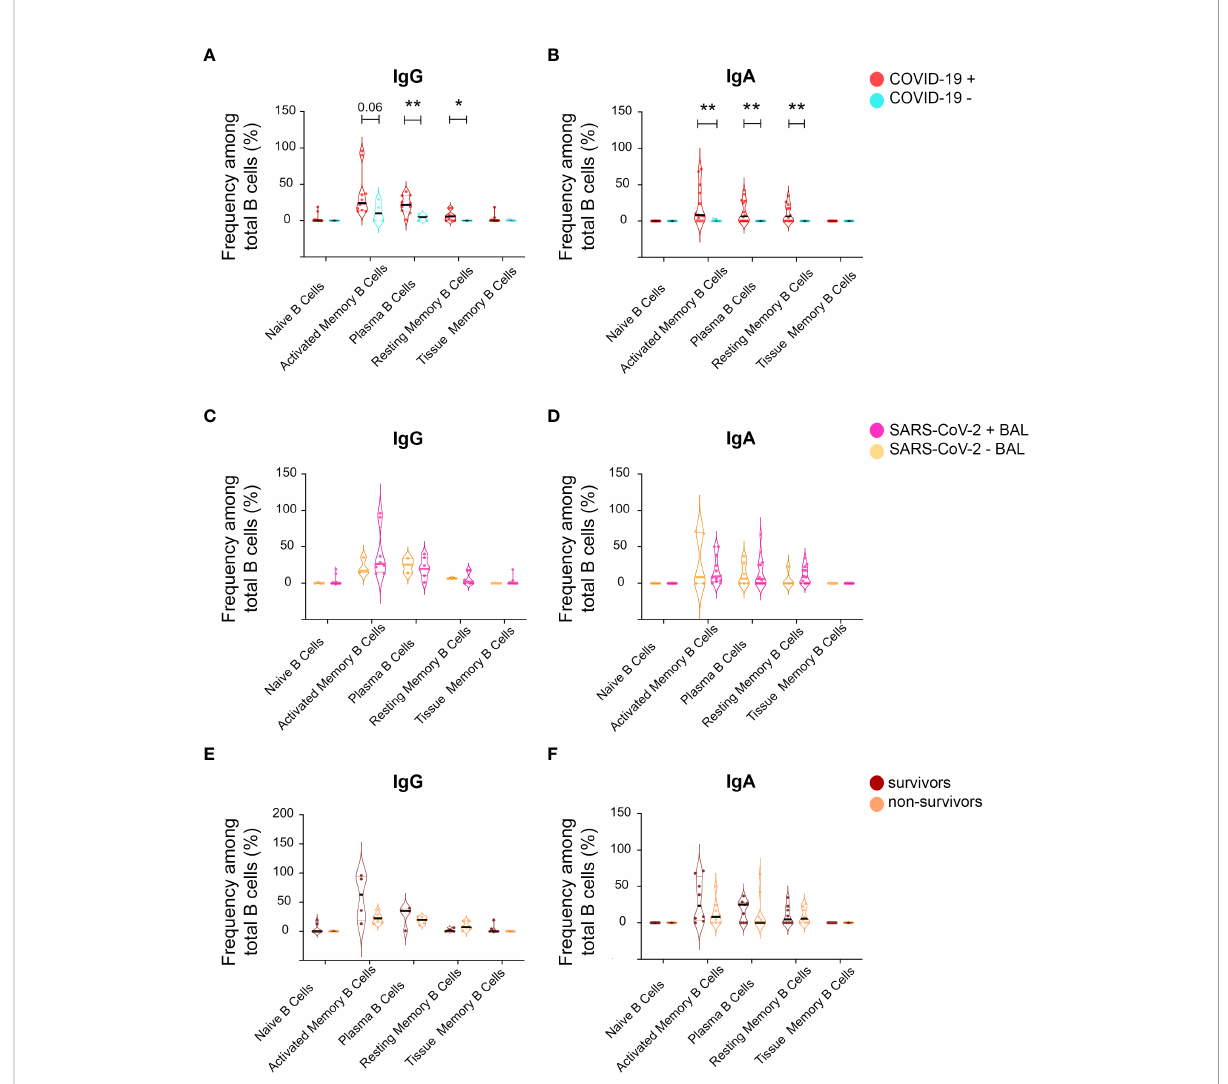
FIGURE 8 Analysis of B-cell phenotype in BAL supernatant from SARS-CoV-2-infected individuals. From total B cells, fi ve B-cell populations were de fi ned including Naïve B cells, activated memory B cells, plasma B cells, resting memory B cells, and tissue memory B cells according to a gating strategy shown in Supplementary Figure 1, which were further labeled for IgG (IgG+) and IgA (IgA+). (A) Frequencies of different IgG+ B-cell populations between COVID-19+ and COVID-19 − individuals in the total B-cell population shown as violin plots. (B) Frequencies of different IgA+ B-cell populations between COVID-19+ and COVID-19 − individuals in the total IgA+ B-cell population shown as violin plots. (C) Frequencies of different IgG+ B-cell populations between SARS CoV-2+ BAL and SARS CoV-2 − BAL individuals in the total IgG+ B-cell population shown as violin plots. (D) Frequencies of different IgA+ B-cell populations between SARS CoV-2+ BAL and SARS CoV-2 − BAL individuals in the total IgA+ B-cell population shown as violin plots. (E) Frequencies of different IgG+ B-cell populations between survivors and non-survivors in the total IgG+ B-cell population shown as violin plots. (F) Comparison of different IgA+ B-cell populations between survivors and non-survivors in the total IgA+ B-cell population shown as violin plots. p-Values were calculated by using Mann – Whitney test *, p < 0.05; **, p <